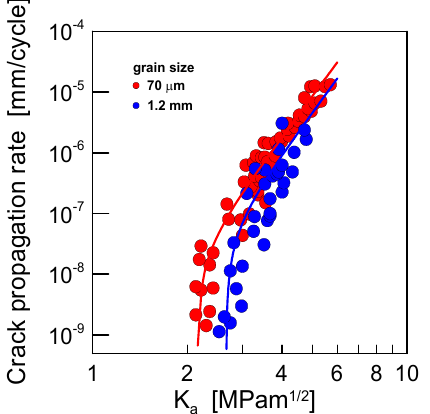
Figure 12: Comparison of crack propagation curves for fine- grained and coarse grained Cu.